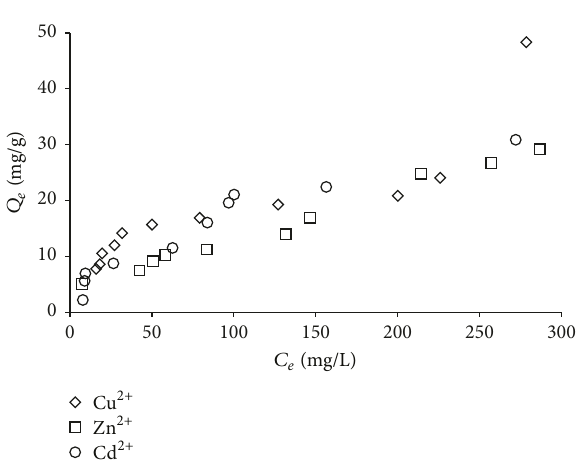
Figure 7: Adsorption capacity of the zirconium-based ferromag- netic sorbent for Cu 2+ , Zn 2+ , and Cd 2+ [experimental conditions: sorbentdosage=1 g/L,contacttime=24 h,andtemperature=25 ∘ C].